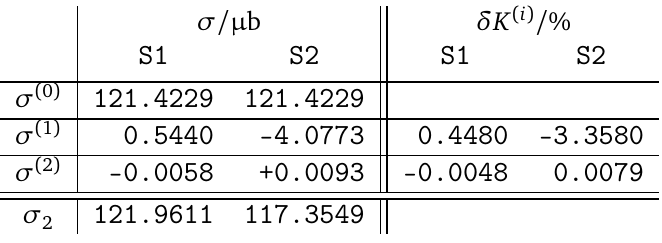
Table 2: Results for the integrated cross section for S1 (without elasticity cut) and S2 (with elasticity cut) at LO, NLO, and NNLO. All digits given are significant compared to the error of the numerical